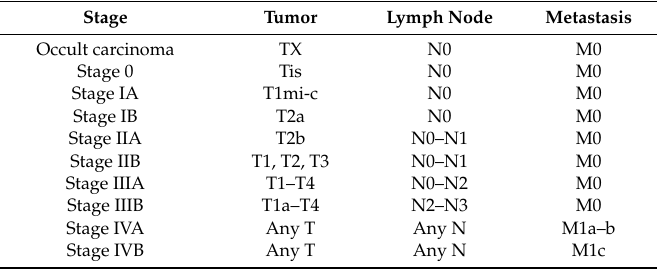
Table 2. Staging of NSCLC according to the International Association for the Study of Lung Cancer [21].